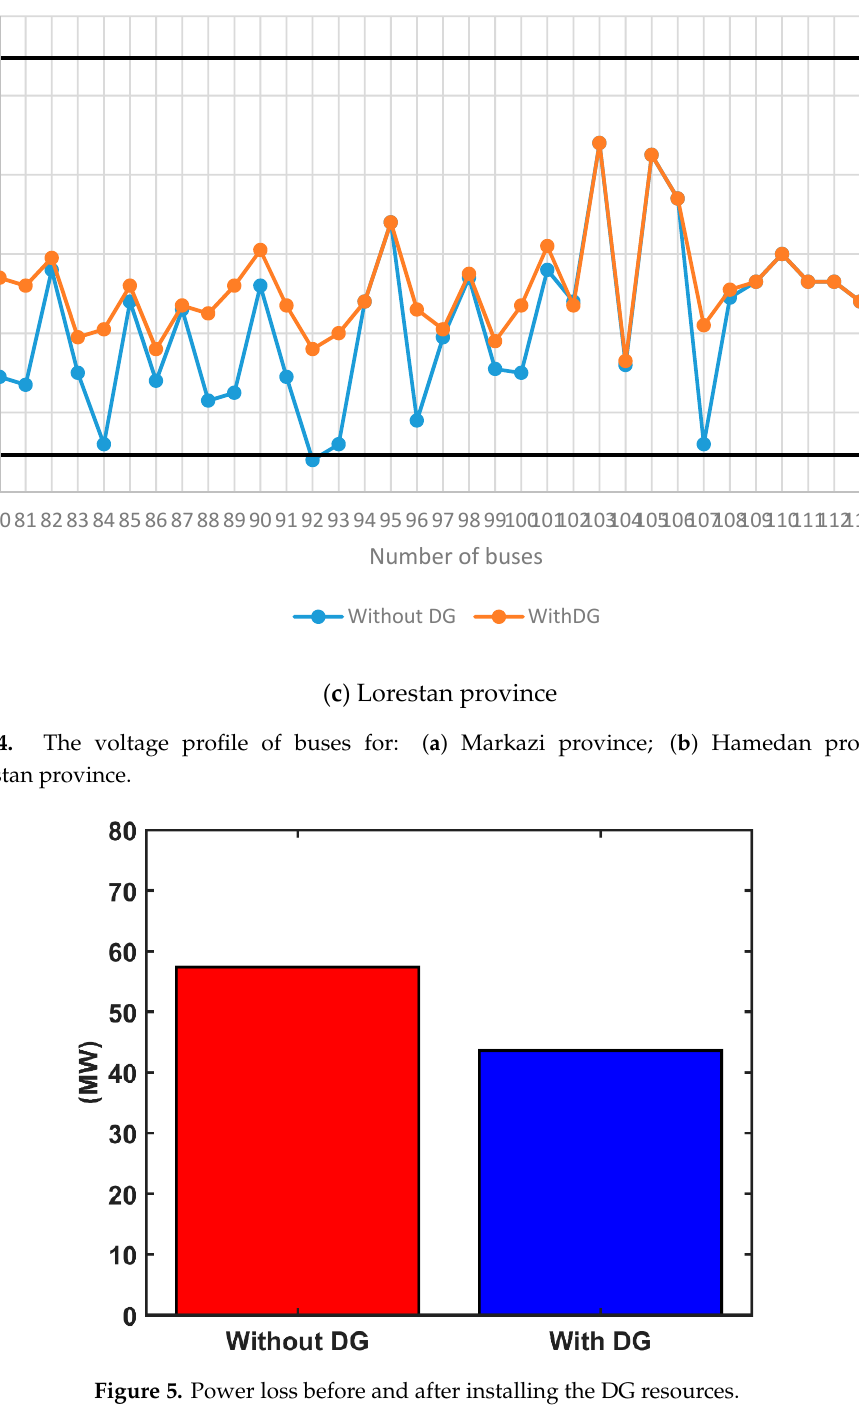
Figure 5. Power loss before and after installing the DG resources.